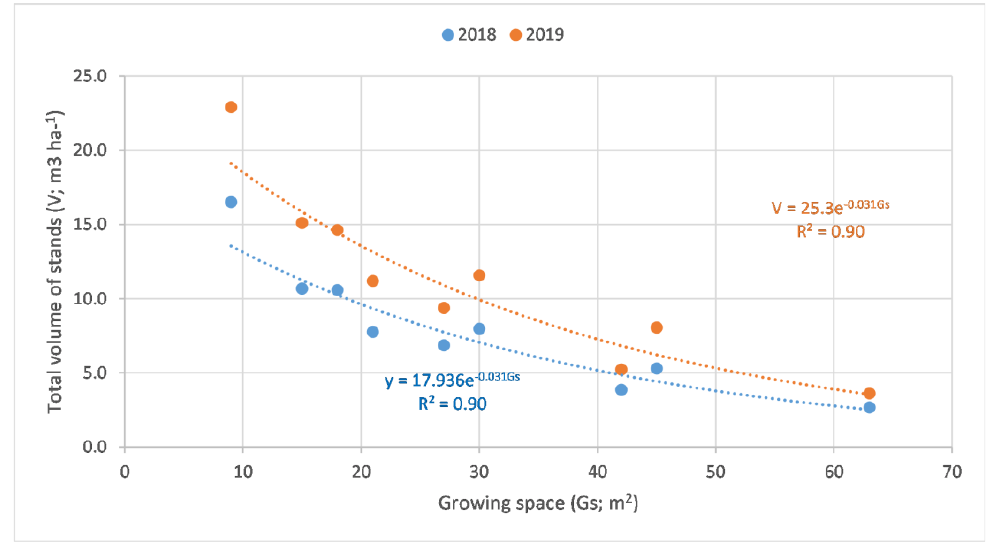
Figure 3. Relationship between the total volume of stands and the growing space per hectare in alley cropping systems at the ages of 4 and 5 ( α = 0.01, n = 9).